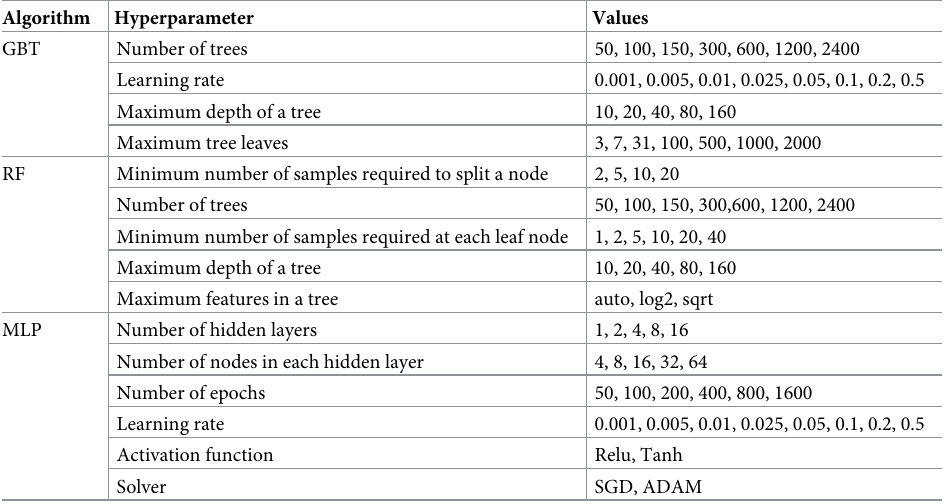
Table 5. Hyperparameter values. Algorithm Hyperparameter